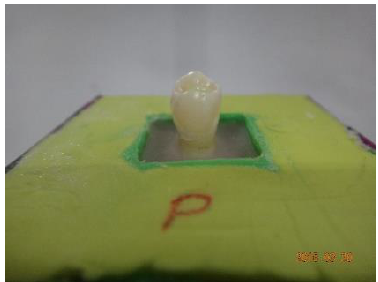
Figure 1: Tooth with 8mm length showing